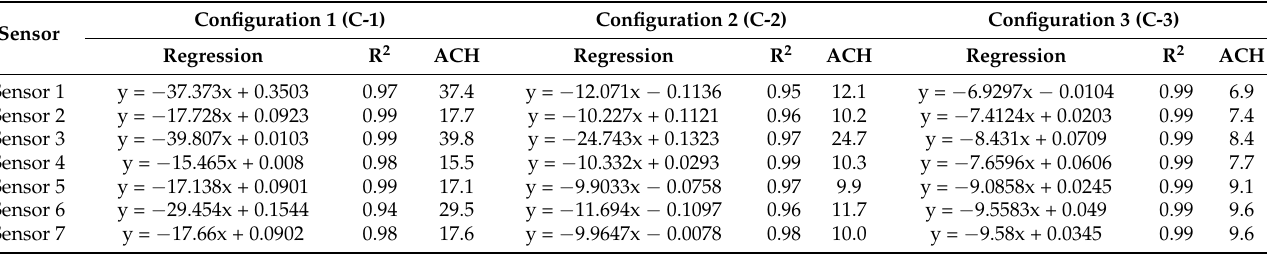
Table A3. Decay curves in Classroom B2-A1.